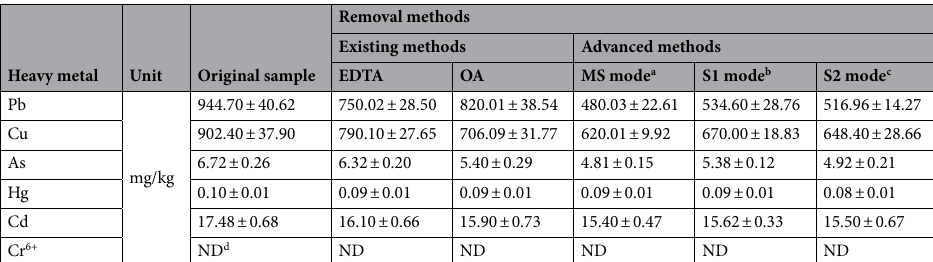
Table 5. Comparison of the heavy metal contents of paper incineration ash following treatment using various removal methods. a Use of EDTA and OA simultaneously. b First step: EDTA; second step: oxalic acid. c First step: oxalic acid; second step: EDTA. d Not